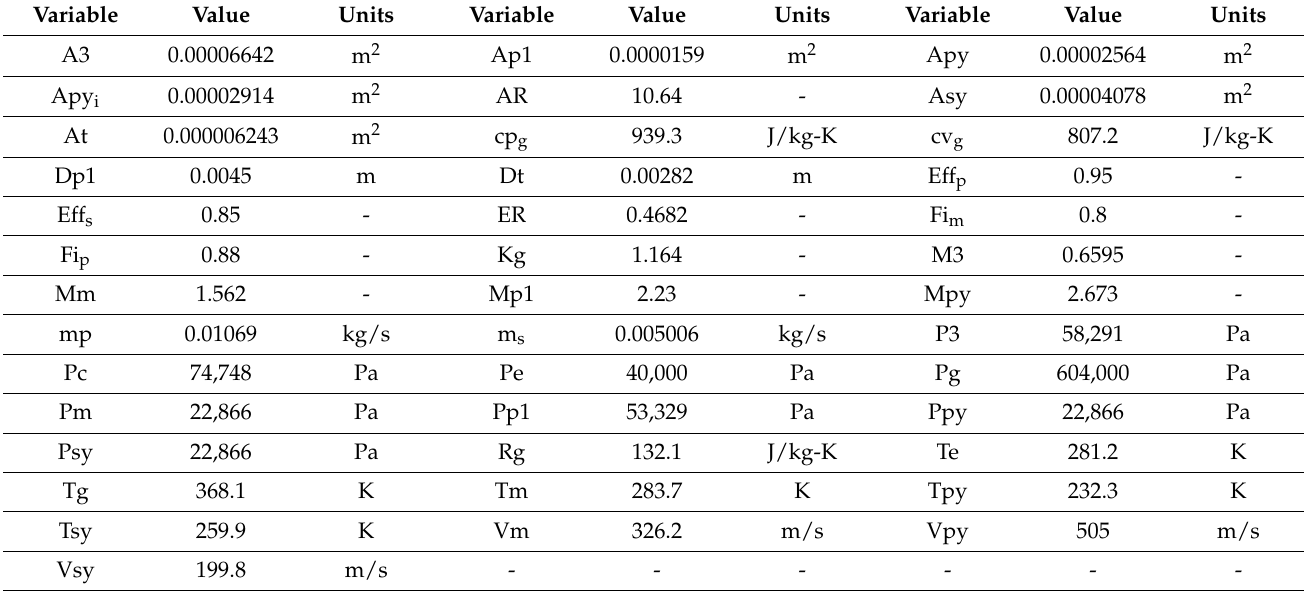
Table A2. Validation of the developed EES model based on the 1-D model of Huang et al. [34].